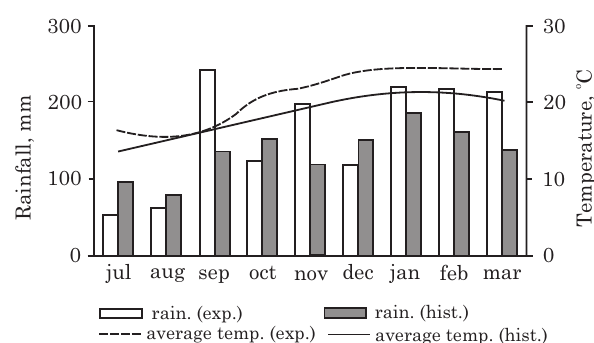
Figure 1. Temperature and rainfall distribution in this study (exp.), compared to the historical data (hist.) from 1954 -